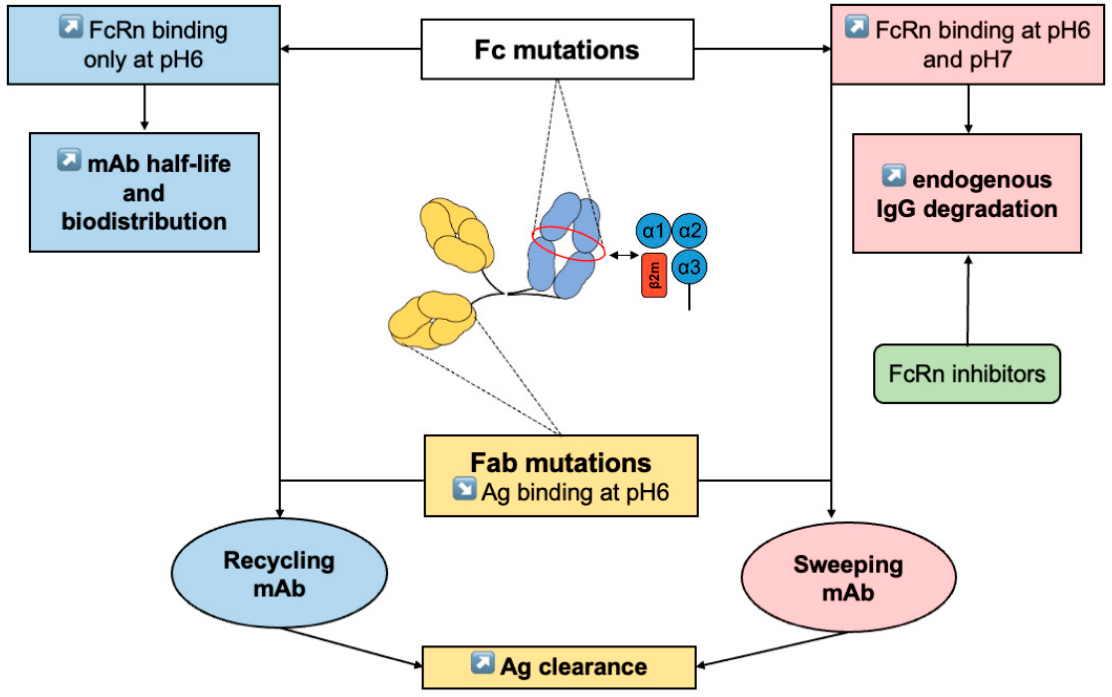
Figure 2. mAb mutations in Fc or Fab IgG. In Fc IgG, mutations can increase binding to FcRn at pH6 only (blue) or at pH6 and pH7 (pink) to increase mAb half-life and biodistribution or endogenous IgG degradation, respectively. FcRn inhibitors (green) can also increase endogenous IgG degradation. In Fab IgG (yellow), mutations can decrease IgG binding at pH6 and can be coupled to Fc IgG mutations (recycling or sweeping mAb) to increase Ag clearance. mAb: monoclonal antibody.